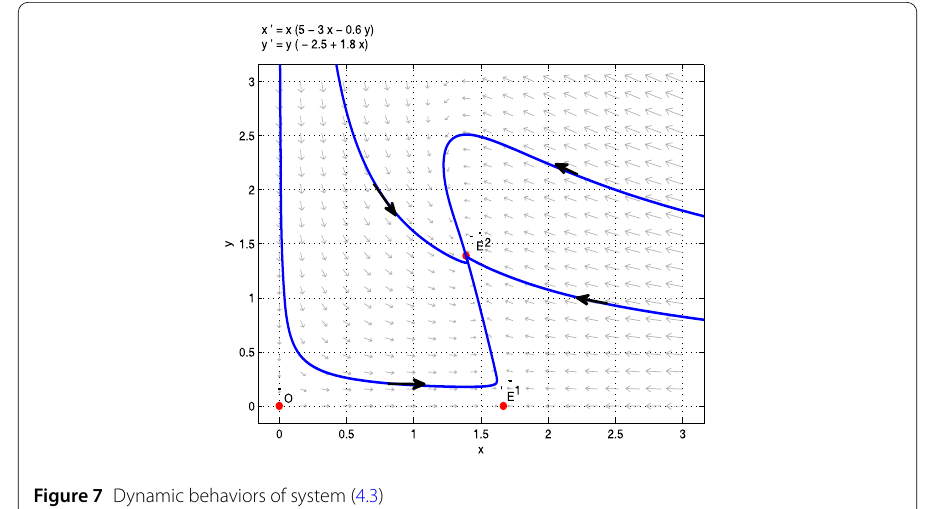
Figure 7 Dynamic behaviors of system (4.3)